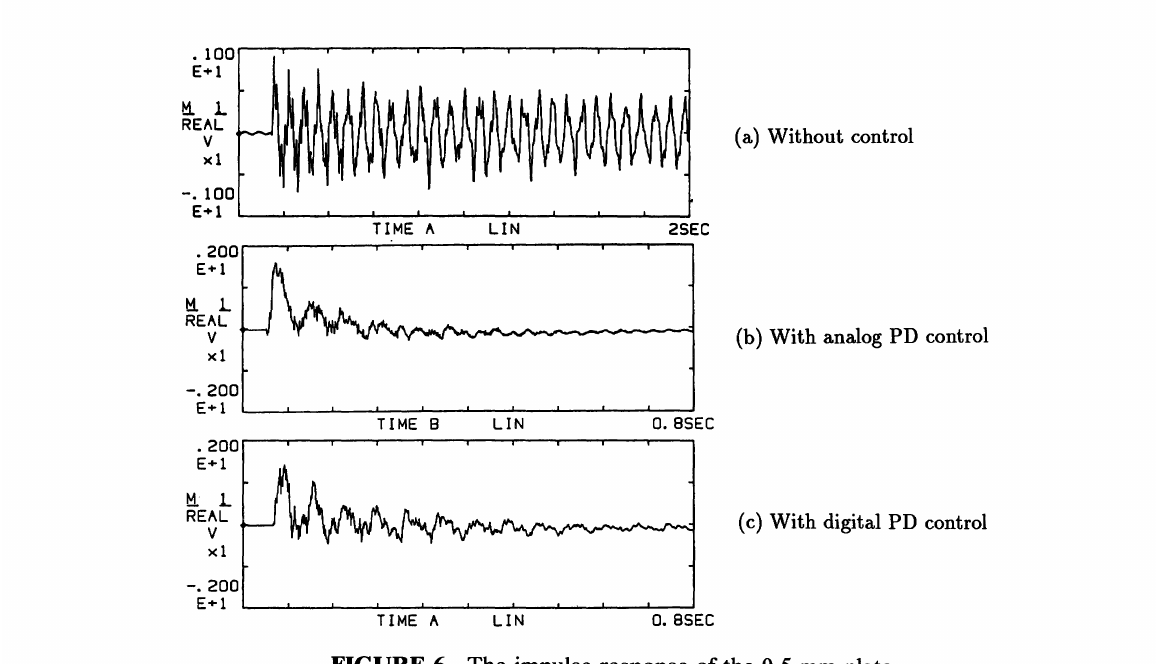
FIGURE 6 The impulse response of the 0.5 mm